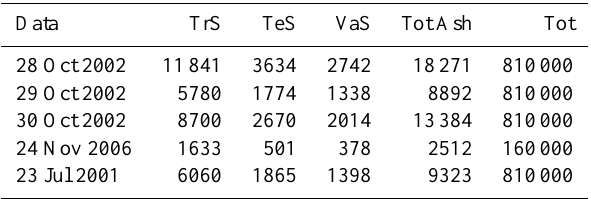
Table 4. The Training, Test and Validations sets for the ash mass retrieval